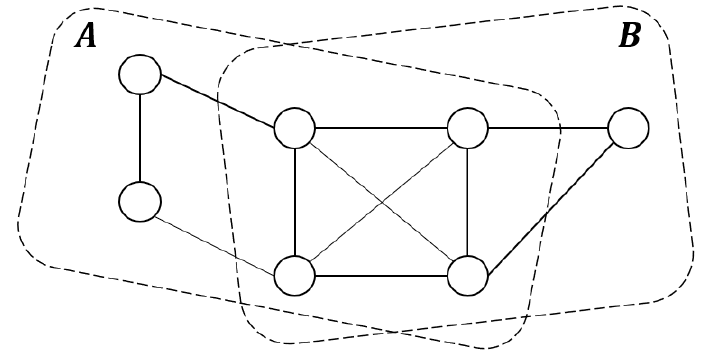
Figure 3. A representation of the structural Markov property for non-decomposable undirected graphs: A ∩ B is complete and separates A from B